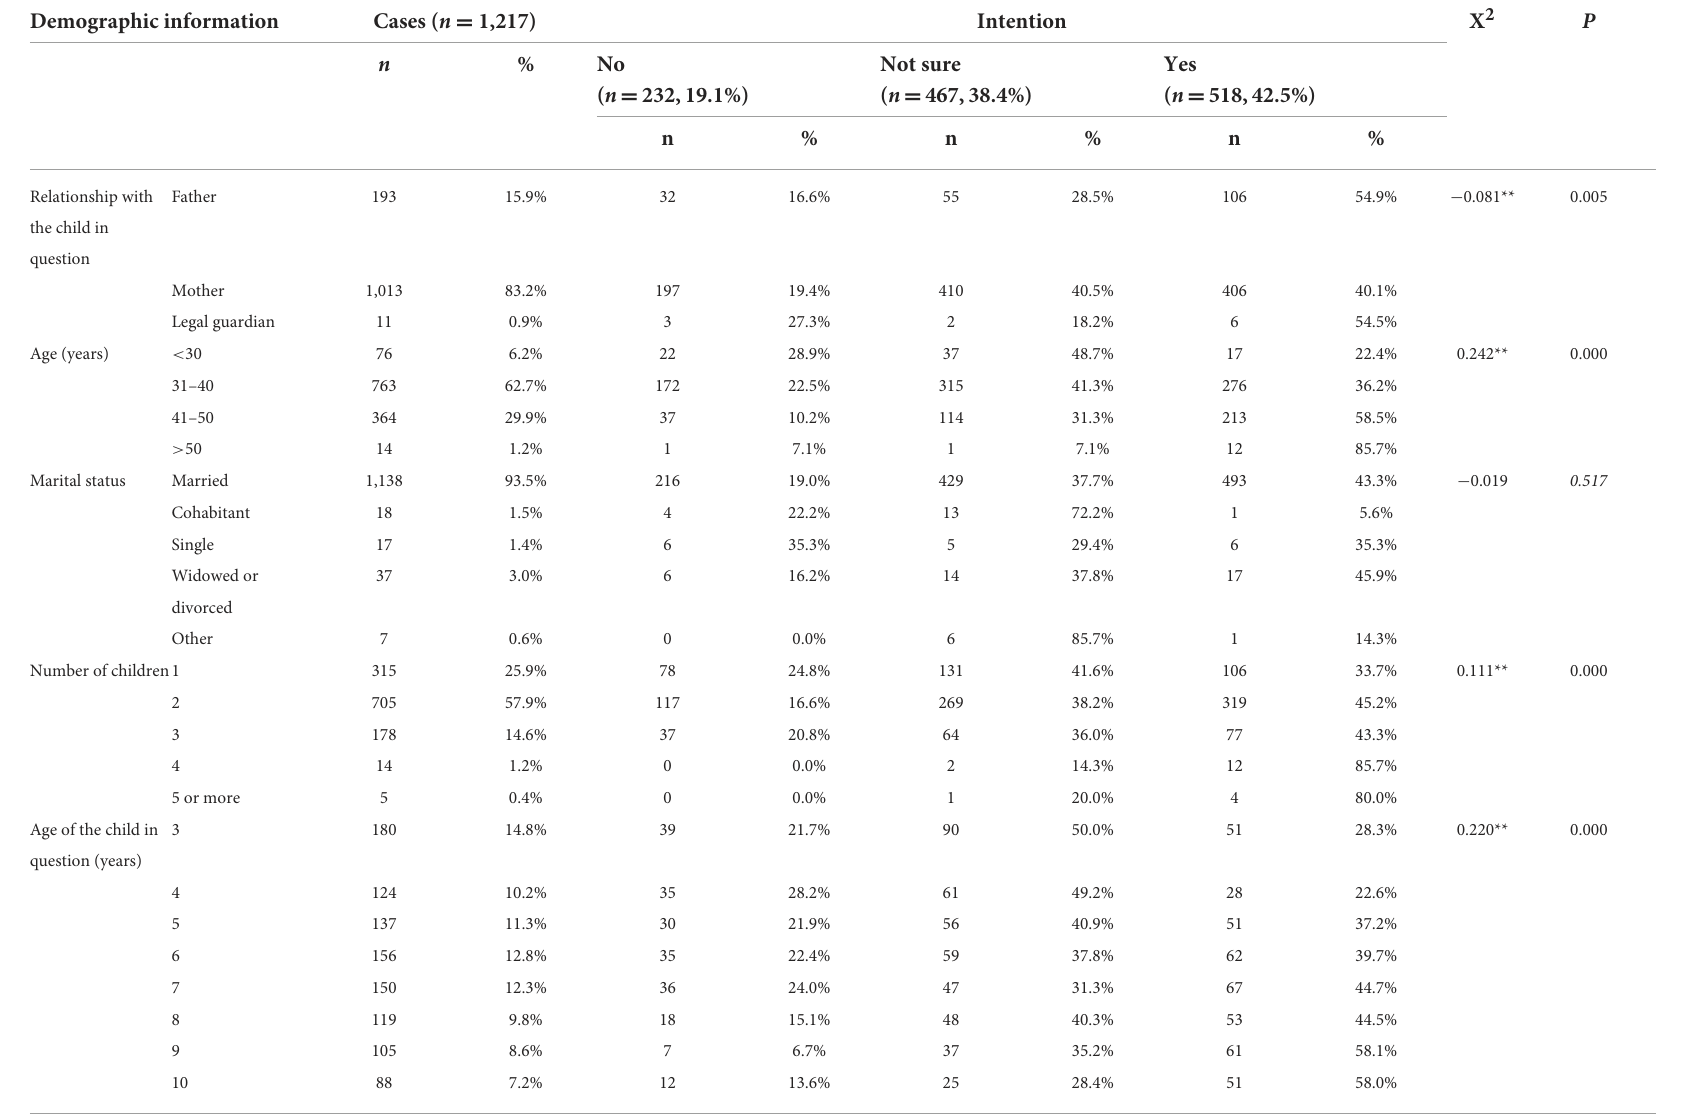
TABLE 1 Respondents’ demographic information ( n =